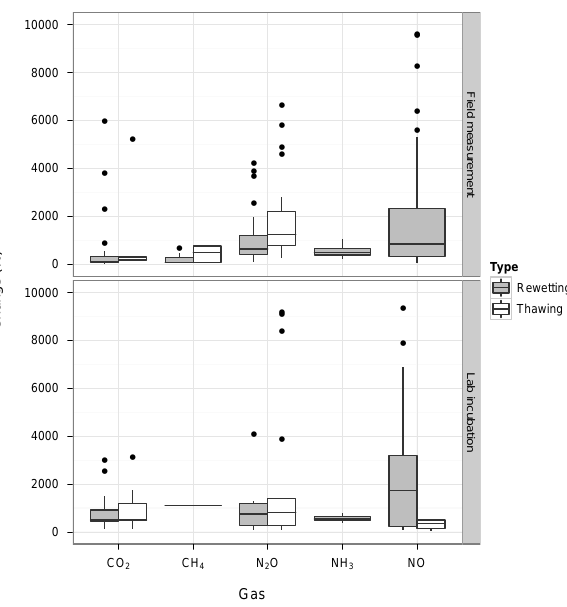
Fig. 4. Change rate (%) of soil gas CO 2 , CH 4 , N 2 O, NO and NH 3 fluxes following soil rewetting and thawing in field and laboratory experiments. Top and bottom of box are 25th and 75th percentiles; whiskers extend to 1.5 × interquartile